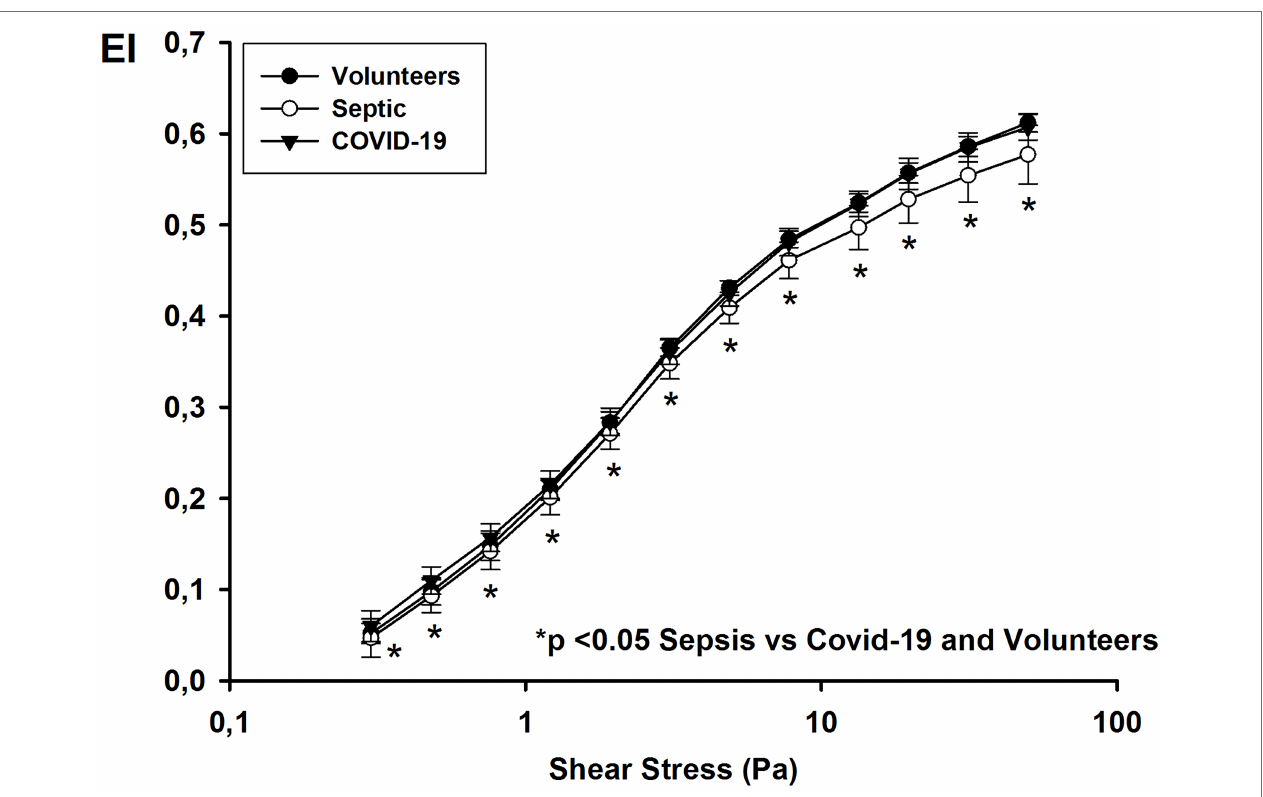
FIGURE 1 | Elongation index at different shear stress values on day 1 in healthy volunteers, and patients with COVID-19 and non-COVID septic.